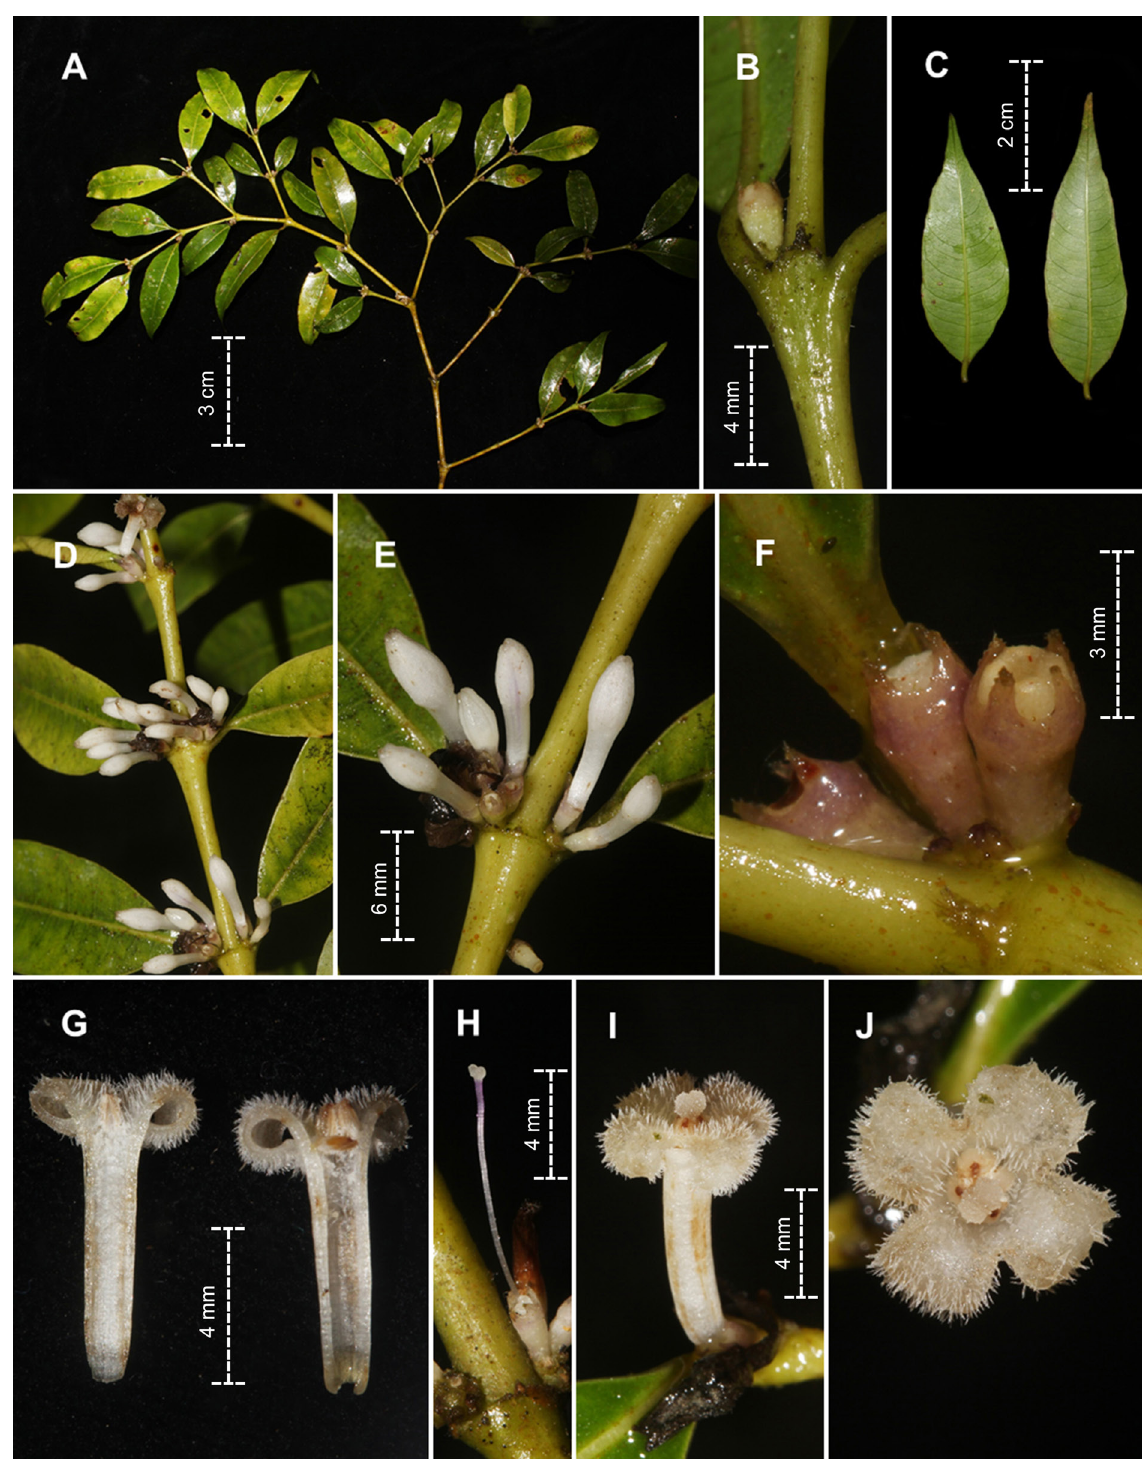
Fig. 4. Lasianthus sonlangensis V.S.Dang, Vuong & Quan sp. nov. A . Branch. B . Stipule and flower bud. C . Abaxial leafs surfaces. D–F . Close-up of infructescence. G–J . Close-up of flowers. Photos by Ba-Vuong Truong on 24 Apr.